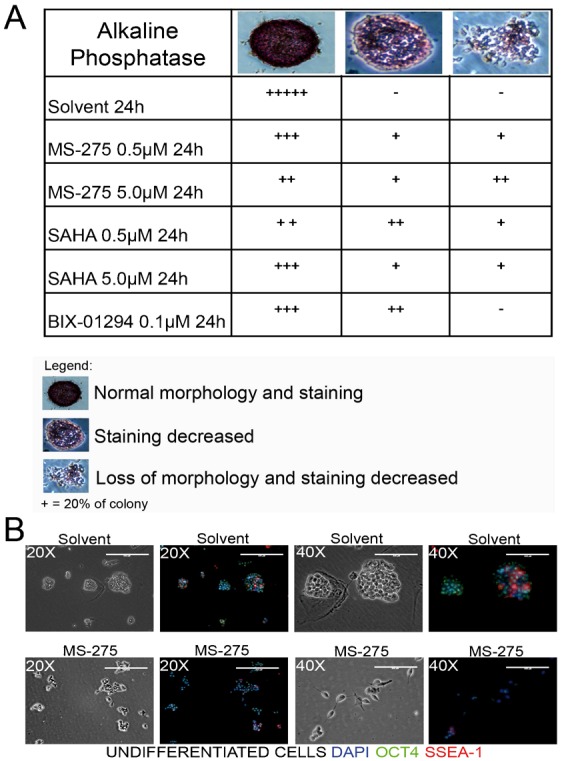
HDAC inhibitors modulate ESC stem cell potential at morphological and molecular level.(A) Effect induced by the indicated compounds on ESC colony morphology and alkaline phosphatase staining. (B) Immunofluorescence of ESC stained for DAPI-OCT4-SSEA-1. Upper panel: control; lower panel: MS-275 at 5.0 µM for 24 h.